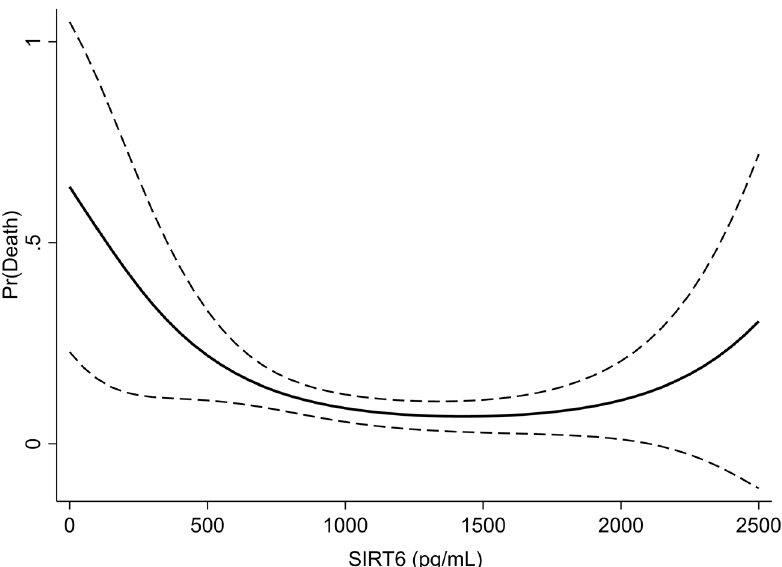
Figure 2. Margin effect of SIRT6 levels for the prediction of the primary outcome.